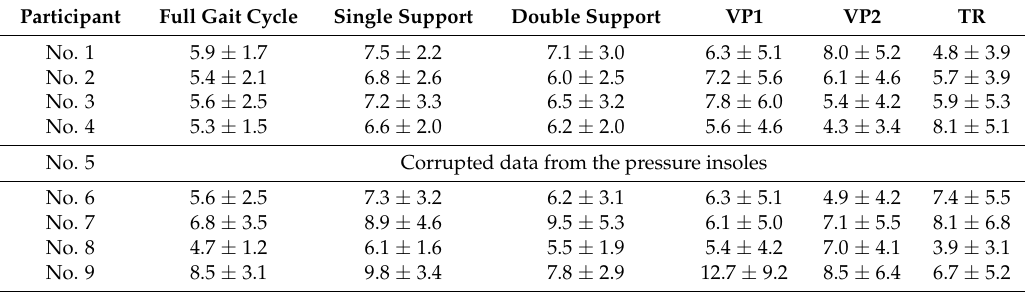
Table 7. Mean and SD of prediction errors for OFW (rRMSE %) based on FH